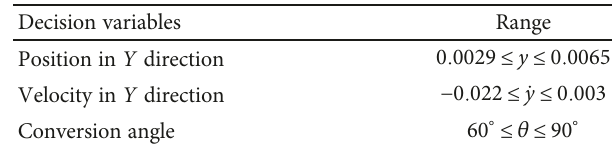
Decision variables